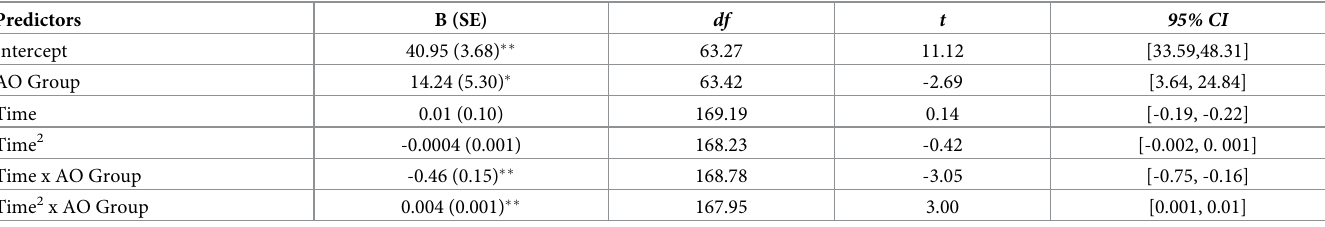
Table 3. Estimates of fixed effects for ruminative tendencies (RRS) over the two-year follow-up period.